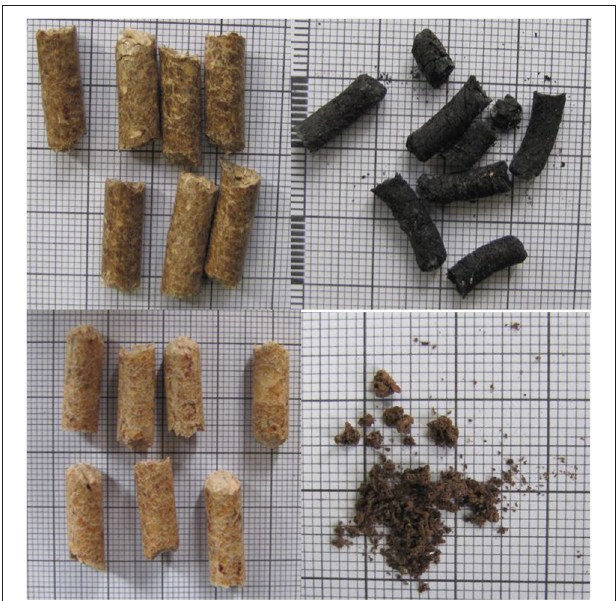
FIGURE 5 | Pellets before (left) and after (right) combustion at 900 ◦ C; t = 1,400s; above: chaff pellets of fine fraction; below: pinewood pellets.